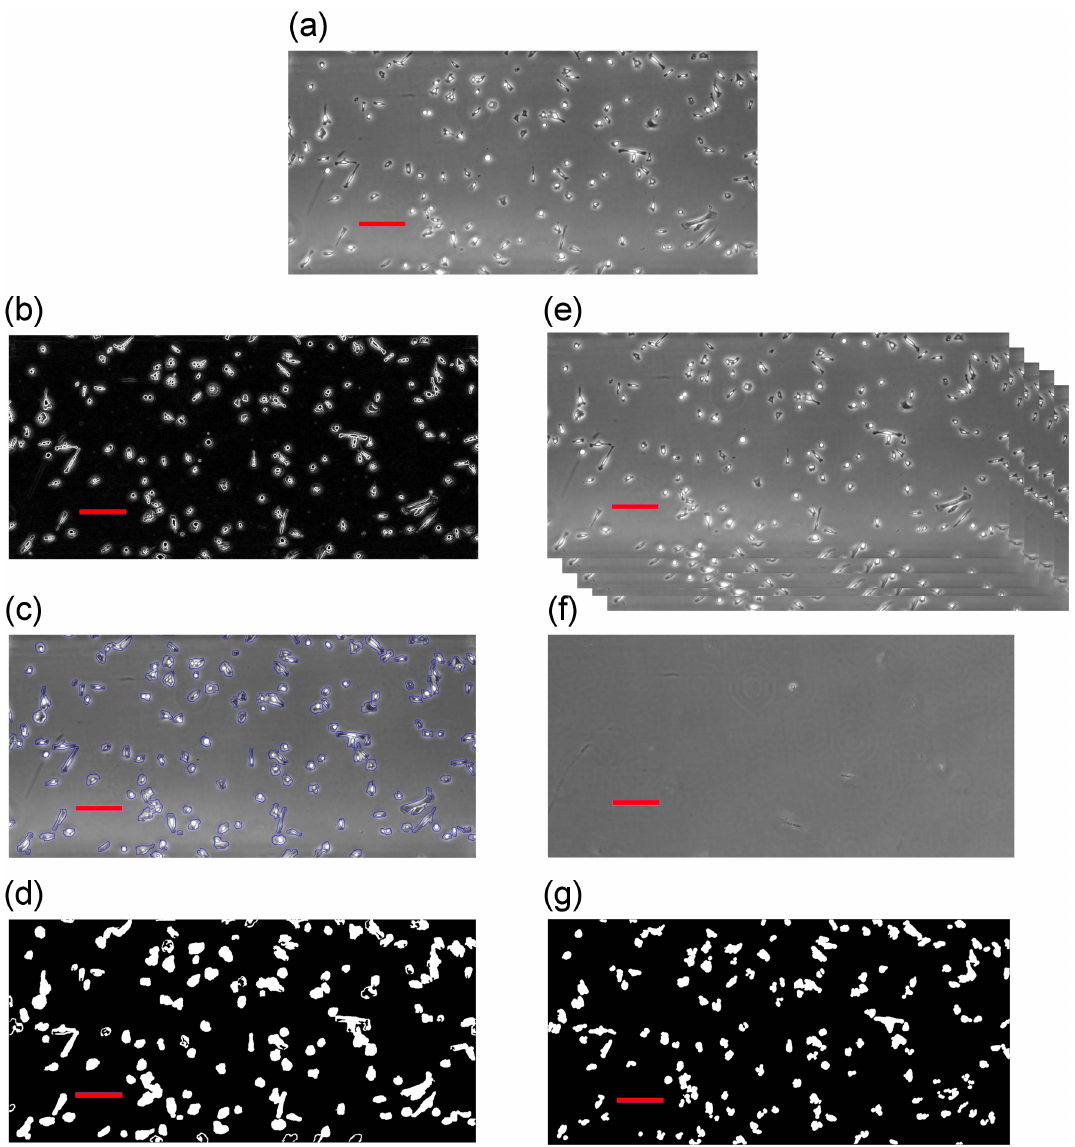
Figure 2. Illustration of two segmentation techniques: ( a ) the original frame from Dataset 1; ( b ) the work of edge detection method [12,38]; ( c ) active contour acting upon the result from edge detection [12,38]; ( d ) binary image as the result from ( b , c ); ( e ) illustrating how we stack all images to reconstruct the static background; ( f ) the work of background reconstruction [37,40]; and, ( g ) binary image resulting from the reconstruction and subtraction algorithms [30]. Bars are 200 µ m in